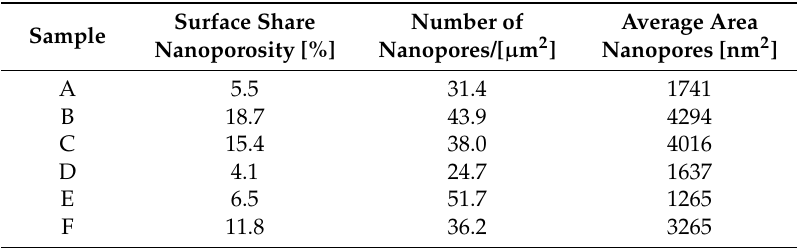
Table 6. Stereological parameter values from computer analysis of surfaces.